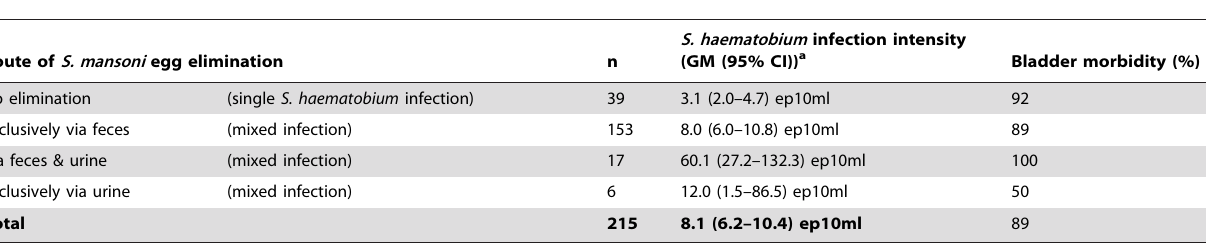
Table 6. S. mansoni egg elimination, infection intensity and bladder morbidity in subjects passing S. haematobium eggs in urine.